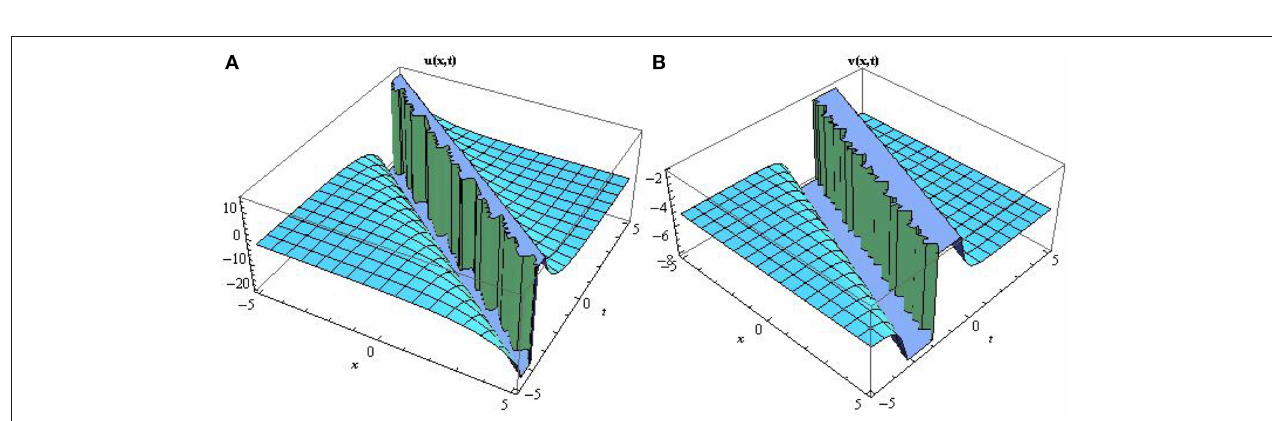
FIGURE 3 | Surface profile of the topological soliton solutions A and B mathematically represented by Equation (40) describing several terminologies in the field of mathematical physics by setting a 1 = 0.4, b 2 = − 0.2, c 3 = 0.1, d = 2, e = 2, f = 0.4.